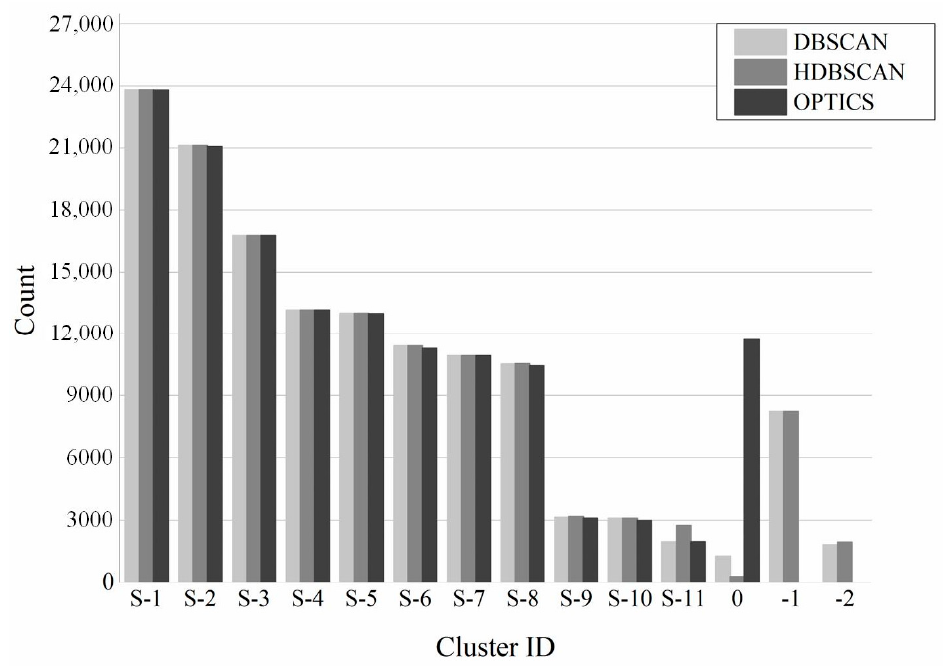
Figure A1. A comparison of values of the candidate sites in each cluster for the DBSCAN, HDBSCAN, and